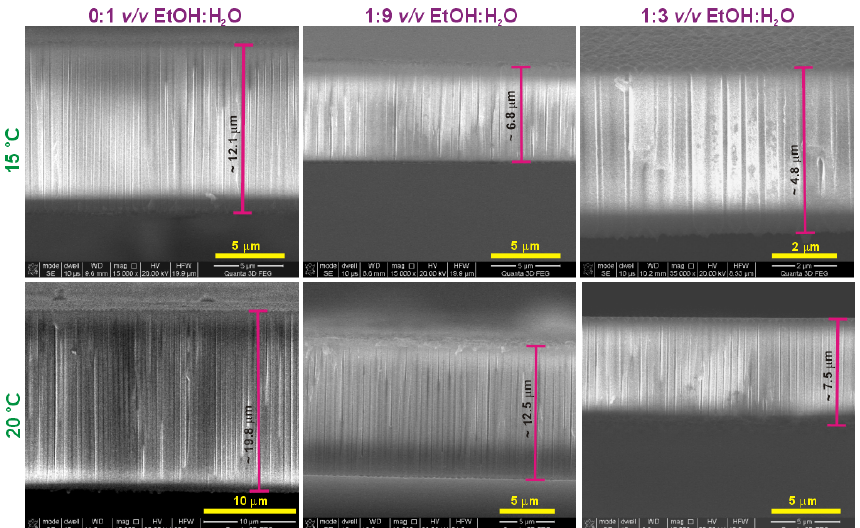
Figure 8. Cross-sectional views of PAAs produced in 0.3 M etidronic acid solutions without (0:1 v / v EtOH:H 2 O) and with two different amounts of ethanol: 1:9 v / v EtOH:H 2 O and 1:3 v / v EtOH:H 2 O at temperature of 15 (first row) and 20 °C (second row).